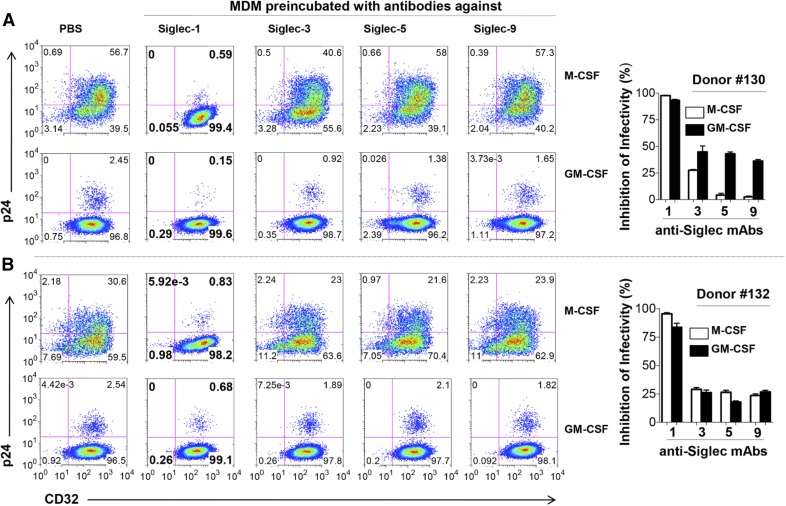
Blocking Siglec-1 receptor significantly decreases HIV-1 infectivity.Primary human monocytes were differentiated into MDM following in vitro culture in GM-CSF or M-CSF media. Triplicate wells of MDMs from donor 130 (A) and donor 132 (B) were preincubated with purified mAbs specific for the Siglec receptors (Siglec-1, -3, -5, or -9) and subsequently infected with US-1 (5 ng p24). MDMs preincubated with PBS served as infection controls. Cells were harvested on day 4 postinfection and analyzed for the presence of intracellular p24 by flow cytometry. Panels show dot plots of US-1–infected GM-CSF– or M-CSF–derived MDMs. Values in the upper right quadrants represent the percentage of infected MDMs. The data from Figs. 4A and B are represented as bar graphs (right side), and shows the percentage inhibition of infectivity (means ± sd) in GM-CSF–derived MDMs (filled bars) or in M-CSF–derived MDMs (open bars). Data are representative of triplicate wells from 3 independent experiments.